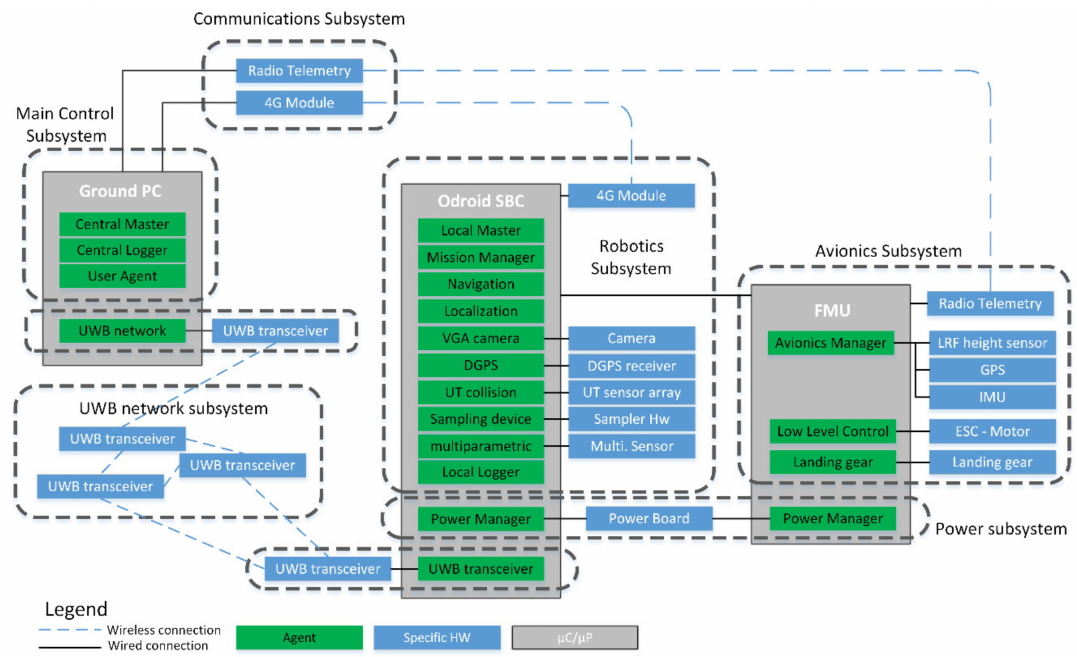
Figure 5. Multi-agent system (MAS) architecture design layout, grouping software, and hardware grouping into subsystems, with detail of hardware (HW) to agent mapping, and agent deployment distribution into the di ff erent devices available. Dashed blue lines represent wireless connections; while black solid lines reference physically connected links; and component boxes are coded as green for software, blue for devices, and grey for computing